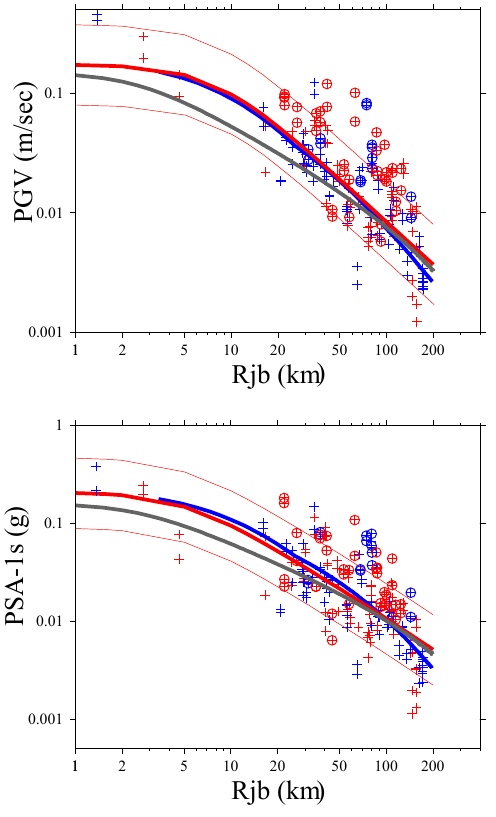
Red and blue symbols represent the observed PGA val- ues in North/North-Western and South/South- Western sectors, respectively. Circles indicate “C” and “D” sites according to NTC08 Italian seismic